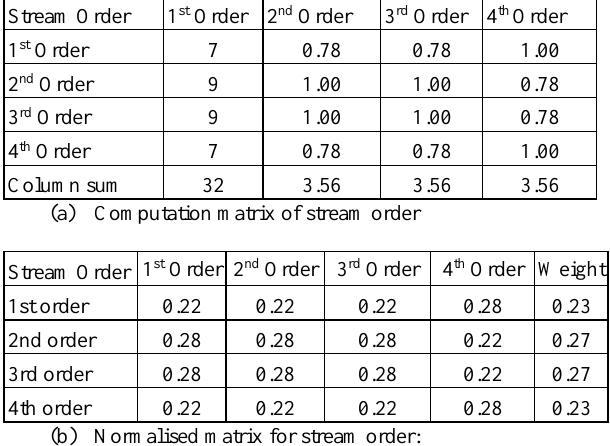
Table 6. Deriving the relative weights of the stream order